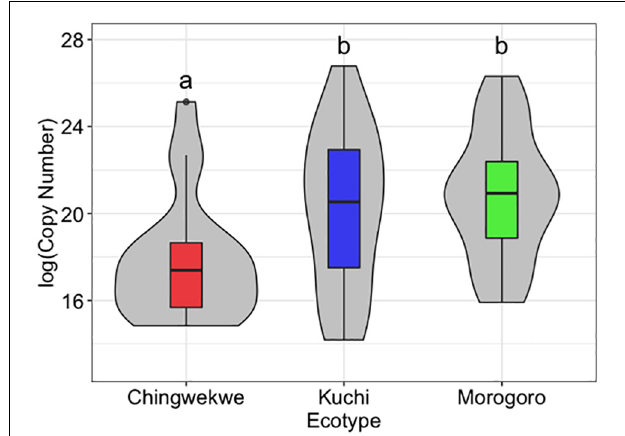
FIGURE 1 | Viral load of Newcastle disease virus (NDV) in the chick embryo lung tissues. The viral load of NDV was assessed in the lung tissue of the chick embryos from each of the three ecotypes, with each ecotype along the x -axis and viral load [log(Copy Number)] on the y -axis. Within the boxplots, the middle line – median, box – Q1-Q3, whiskers – range, dots – outliers. The violin plots show the distribution of samples. The Ching’wekwe has a significantly lower viral load than the other two ecotypes ( p -value <